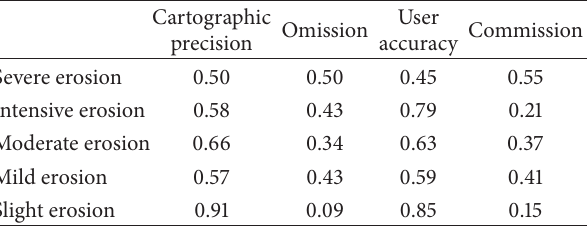
Table 3: Precision index of the quantity of FT